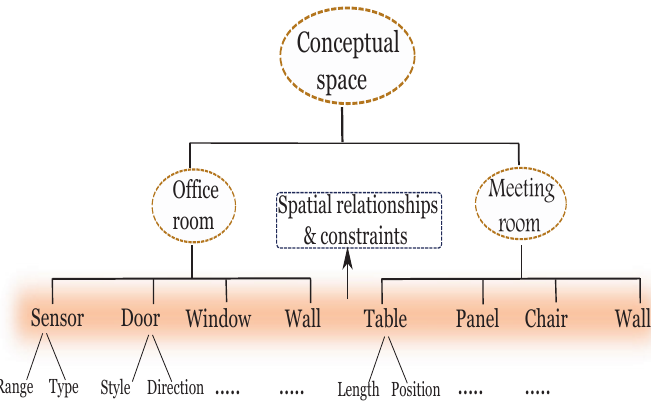
Figure 8: Example of an object-oriented model of an indoor